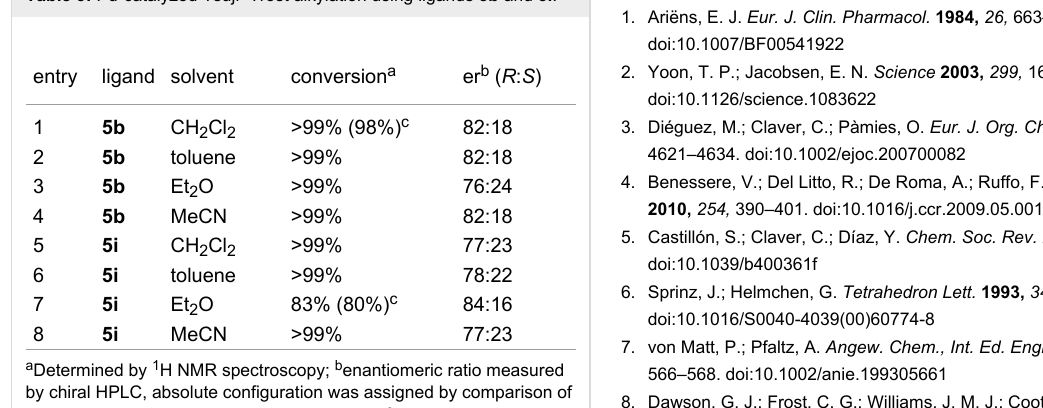
Table 3: Pd-catalyzed Tsuji–Trost alkylation using ligands 5b and 5i .